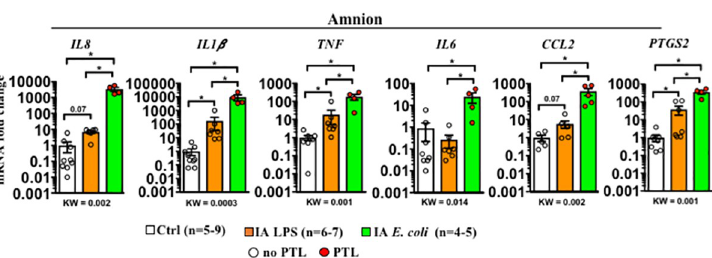
Fig 3. Higher inflammation in the amnion by live E . coli compared to LPS. Inflammatory cytokine mRNAs in different rhesus IUI models were measured in surgically isolated amnion tissue by qPCR. Average mRNA values are fold increases over the average value for the control group after internally normalizing to the housekeeping 18S RNA. Data are mean, SEM. A p -value for 3 group comparison by KW nonparametric test is shown in each panel, with post hoc analysis by DSCF method showing � p < 0.05 between comparators. Red circles denote animals with PTL, while clear circles denote animals without PTL. See S1 Data for numerical values. DSCF, Dwass–Steel–Critchlow–Fligner; IA, intra-amniotic; IUI, intrauterine infection/inflammation; KW, Kruskal–Wallis; LPS, lipopolysaccharide; PTL, preterm labor; qPCR, quantitative polymerase chain